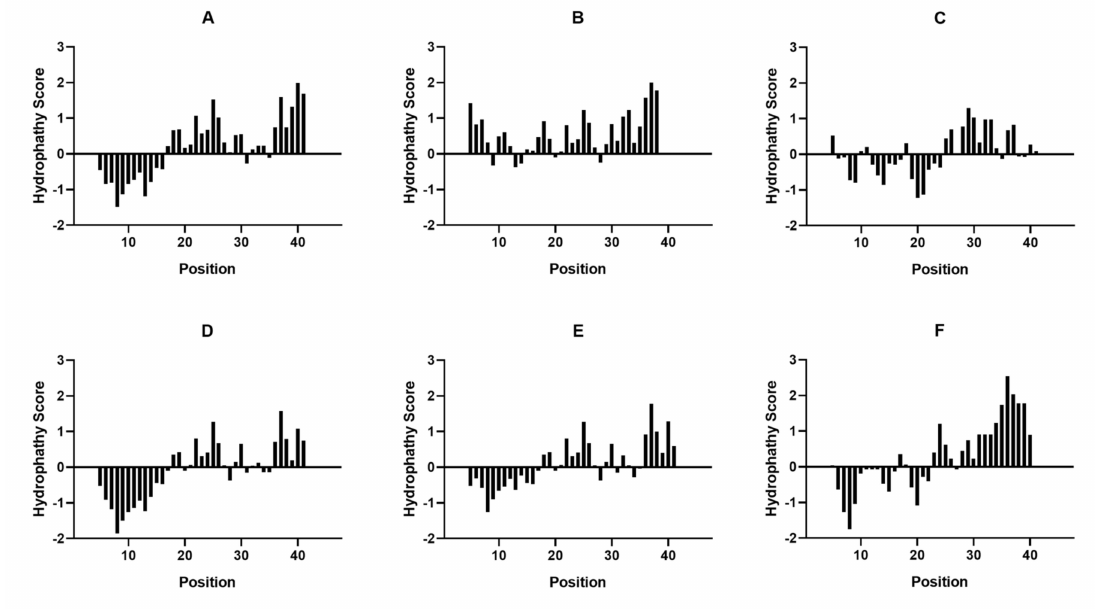
Figure 2. Hydropathy plot for CaNB-BD of CaNA preparated in the Expasy Protscale Website according to the Kyte and Doolittle algorithm. ( A ) CaNB-BD in Hs CaNA α , ( B ) CaNB-BD in Tc CaNA1, ( C ) CaNB-BD in Tc CaNA2, ( D ) CaNB-BD in L sppCaNA1, ( E ) CaNB-BD in L sppCaNA1_var, and ( F ) CaNB-BD in L